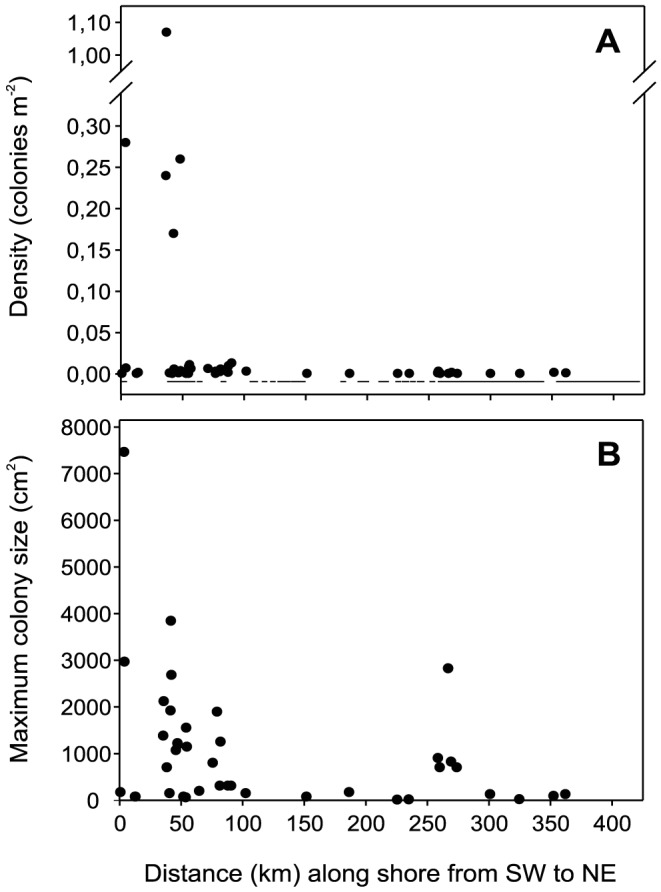
Density and maximum colony size of Oculina patagonica along the Catalan coast.A) Current coral density (colonies m−2) in the locations at which the species was observed along the linear length of the Catalan coast (km). Horizontal lines below the zero line indicate locations at which O. patagonica was not encountered. B) Maximum colony size (cm2) in the locations at which the species was observed in 2010.